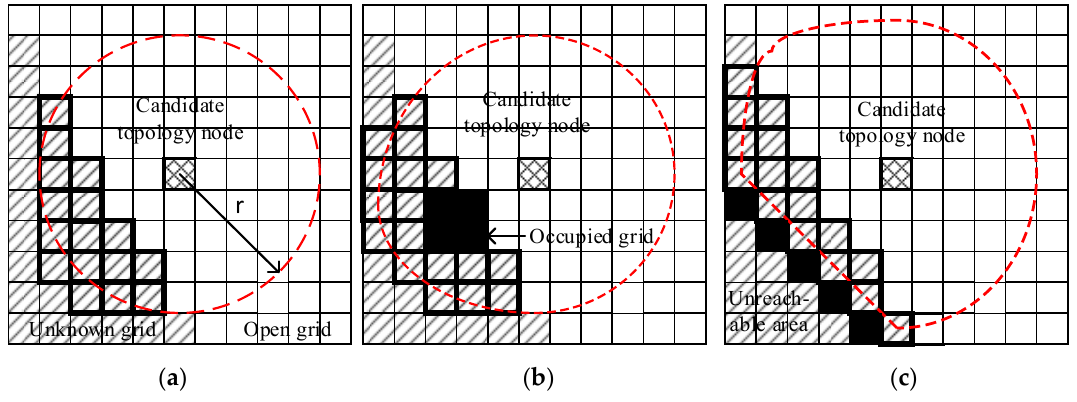
Figure 3. Calculating the information gain around the candidate topology node: ( a ) no obstacle; ( b ) cluster obstacle; ( c ) boundary obstacle.